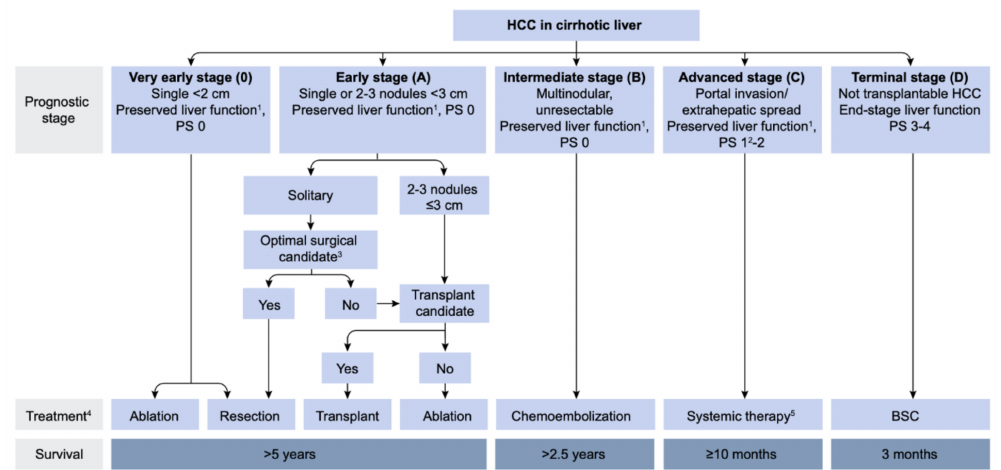
Figure 1. European Association for the Study of the Liver (EASL) clinical practice guidelines 2018 on hepatocellular carcinoma. Reprinted with permission from Ref. [6]. Abbreviations: PS, performance status; BSC, best supportive